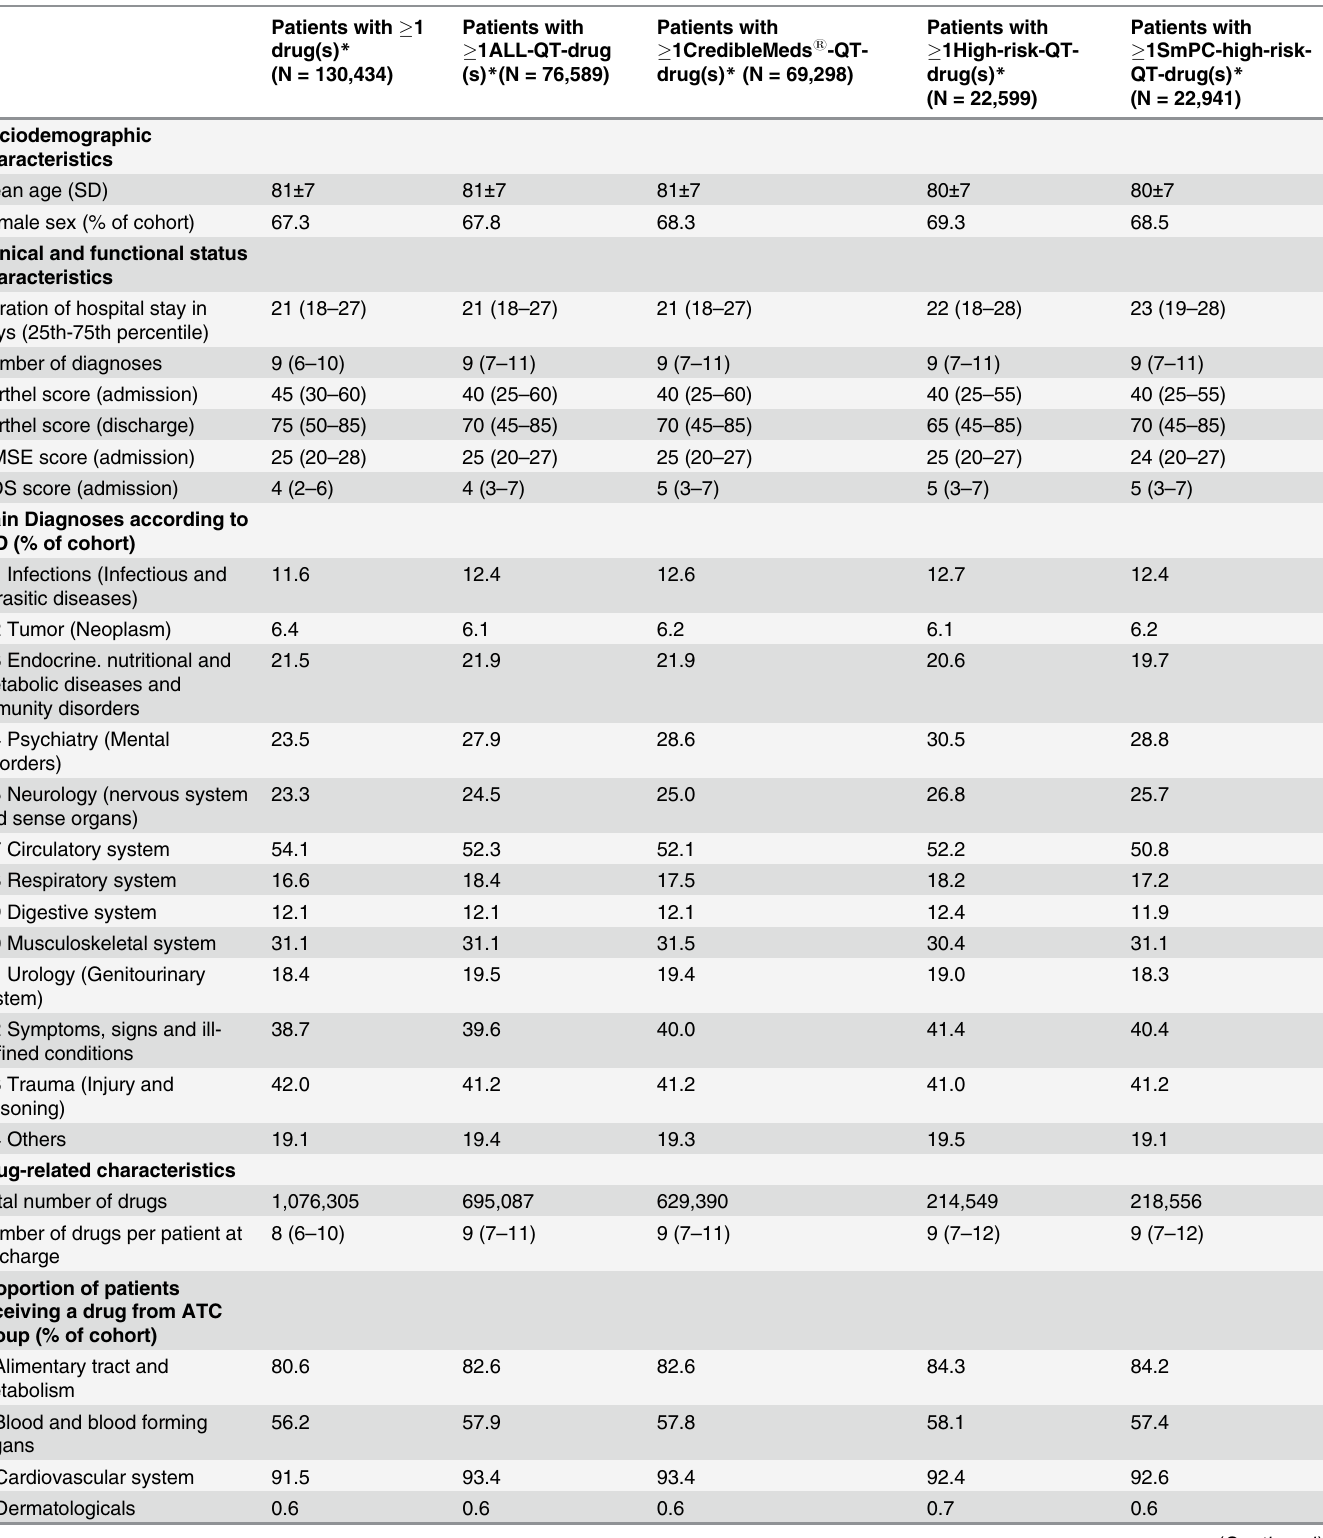
Table 2. Characteristics of the study